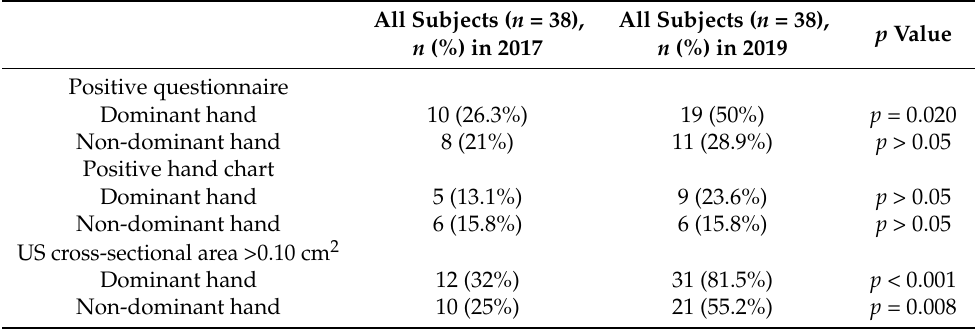
Table 4. Prevalence of positive questionnaire, positive hand chart and cross-sectional area >0.10 cm 2 in 2017 and